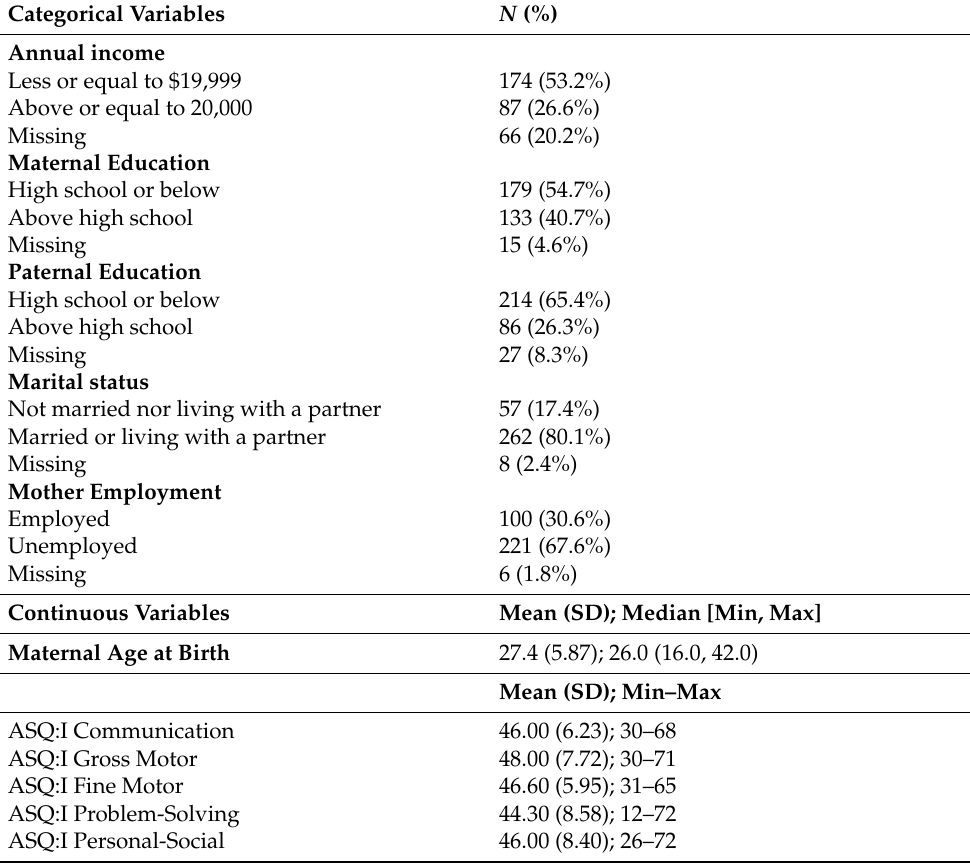
Table 2. Demographic characteristics and ASQ:I domain scores for study participants and ASQ:I scores ( N = 327).